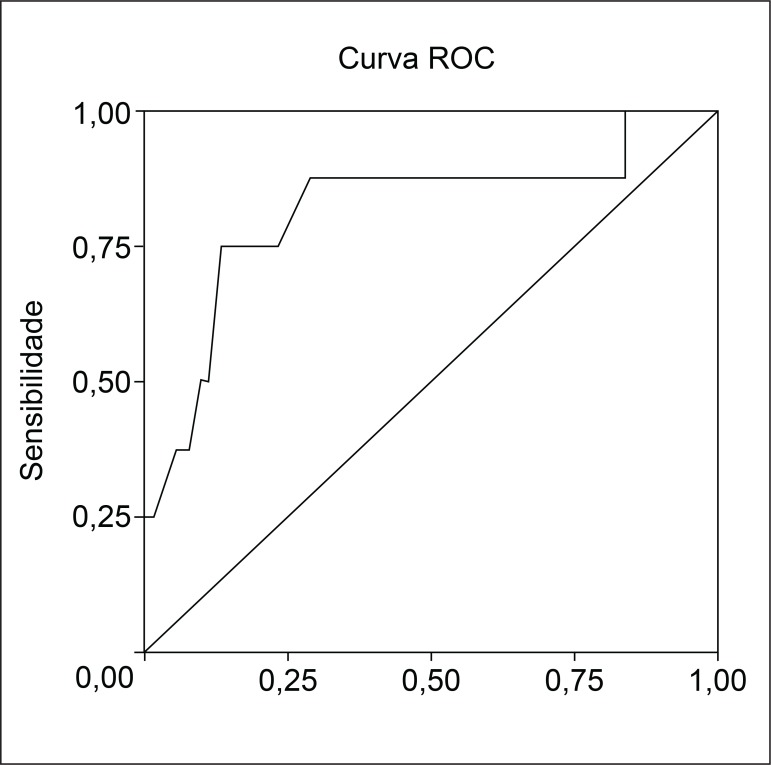
Curva ROC para o modelo fuzzy. Taubaté, 2005-2006